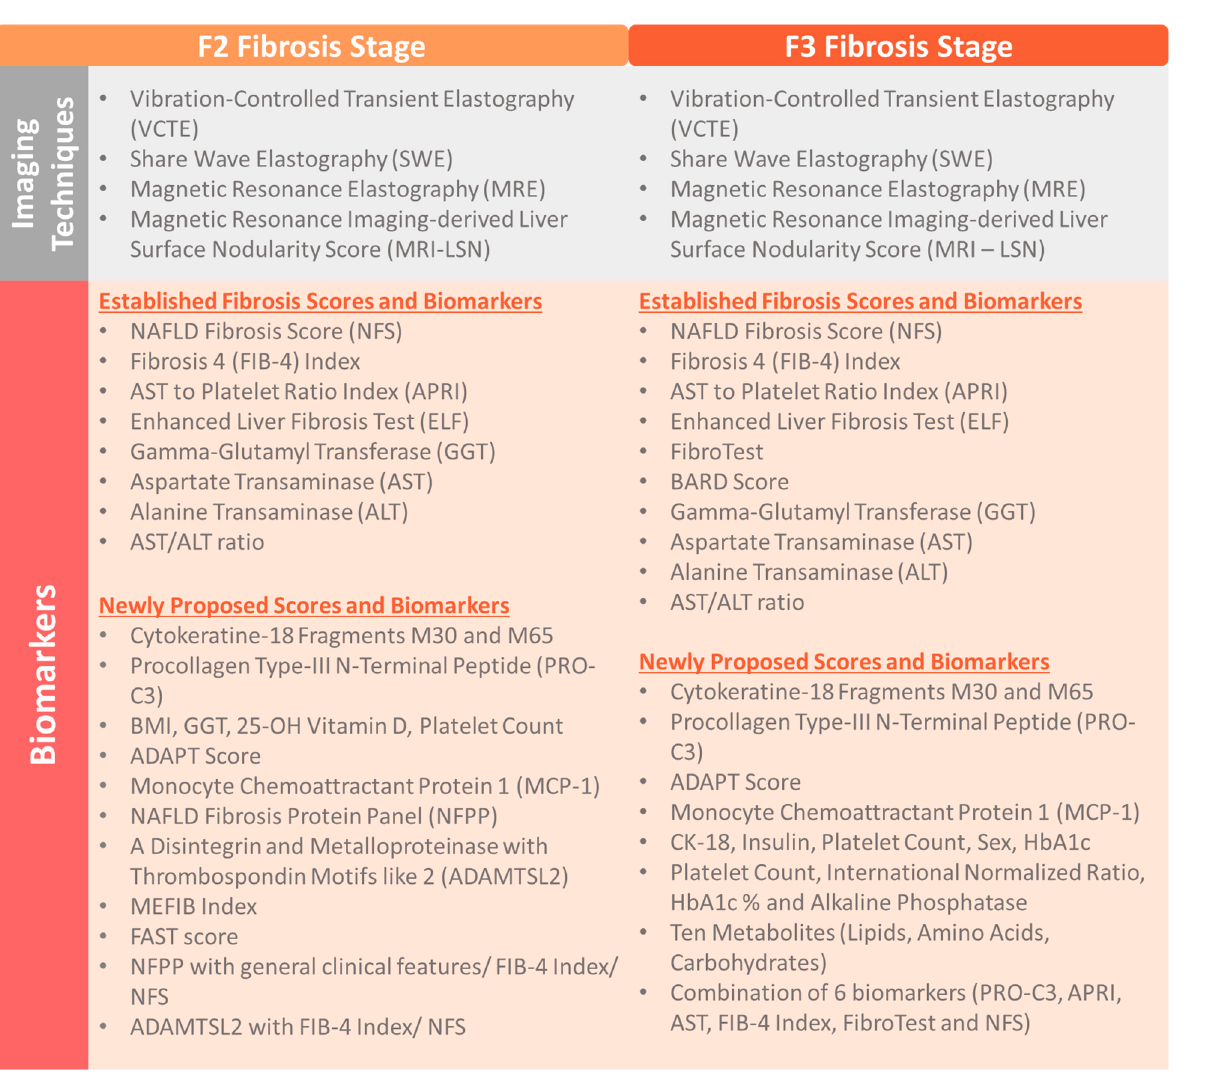
Figure 2. Summary of diagnostic modalities obtained in the SLR.